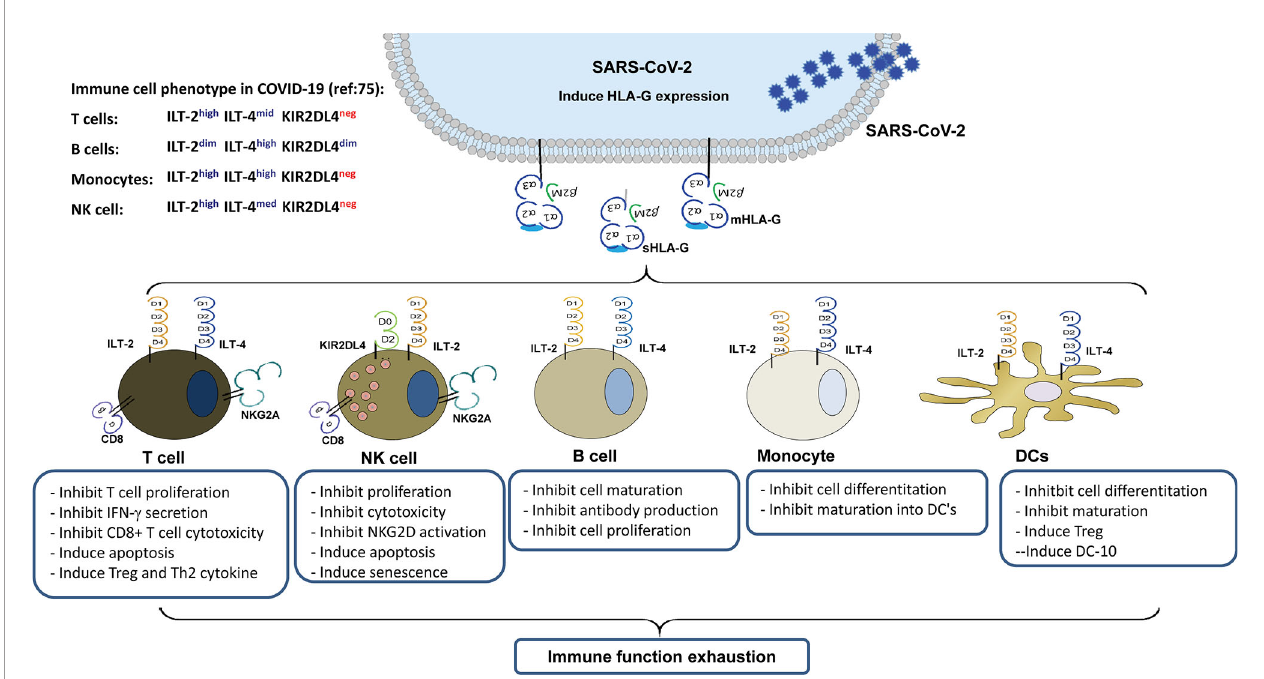
FIGURE 1 | Immune suppression mediated by up-regulated HLA-G expression in virus infected cells and its interaction with immune receptors expressed on different types of immune cells during SARS-CoV-2